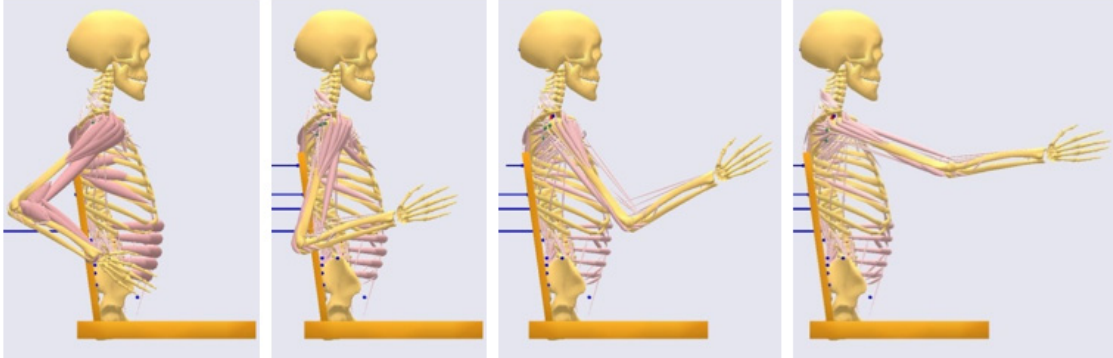
Figure 9. Simulation of movement and human muscle forces when propelling a wheelchair with the Wheelchair Cam-thread Drive (WCD).